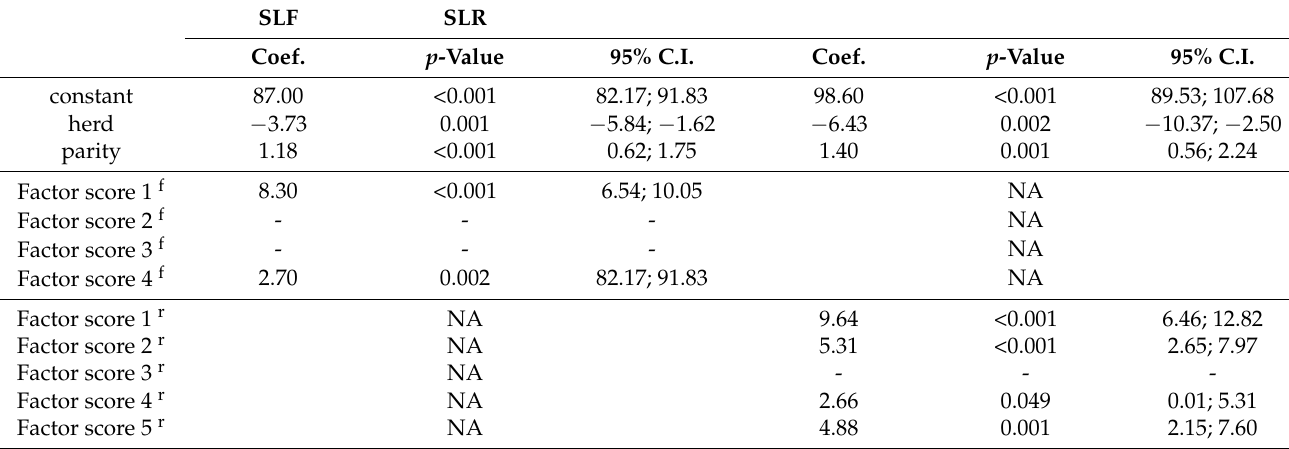
f produced factor score after factor analysis for claw lesion scores in front feet; r produced factor score after factor analysis for claw lesion scores in rear feet; NA: not